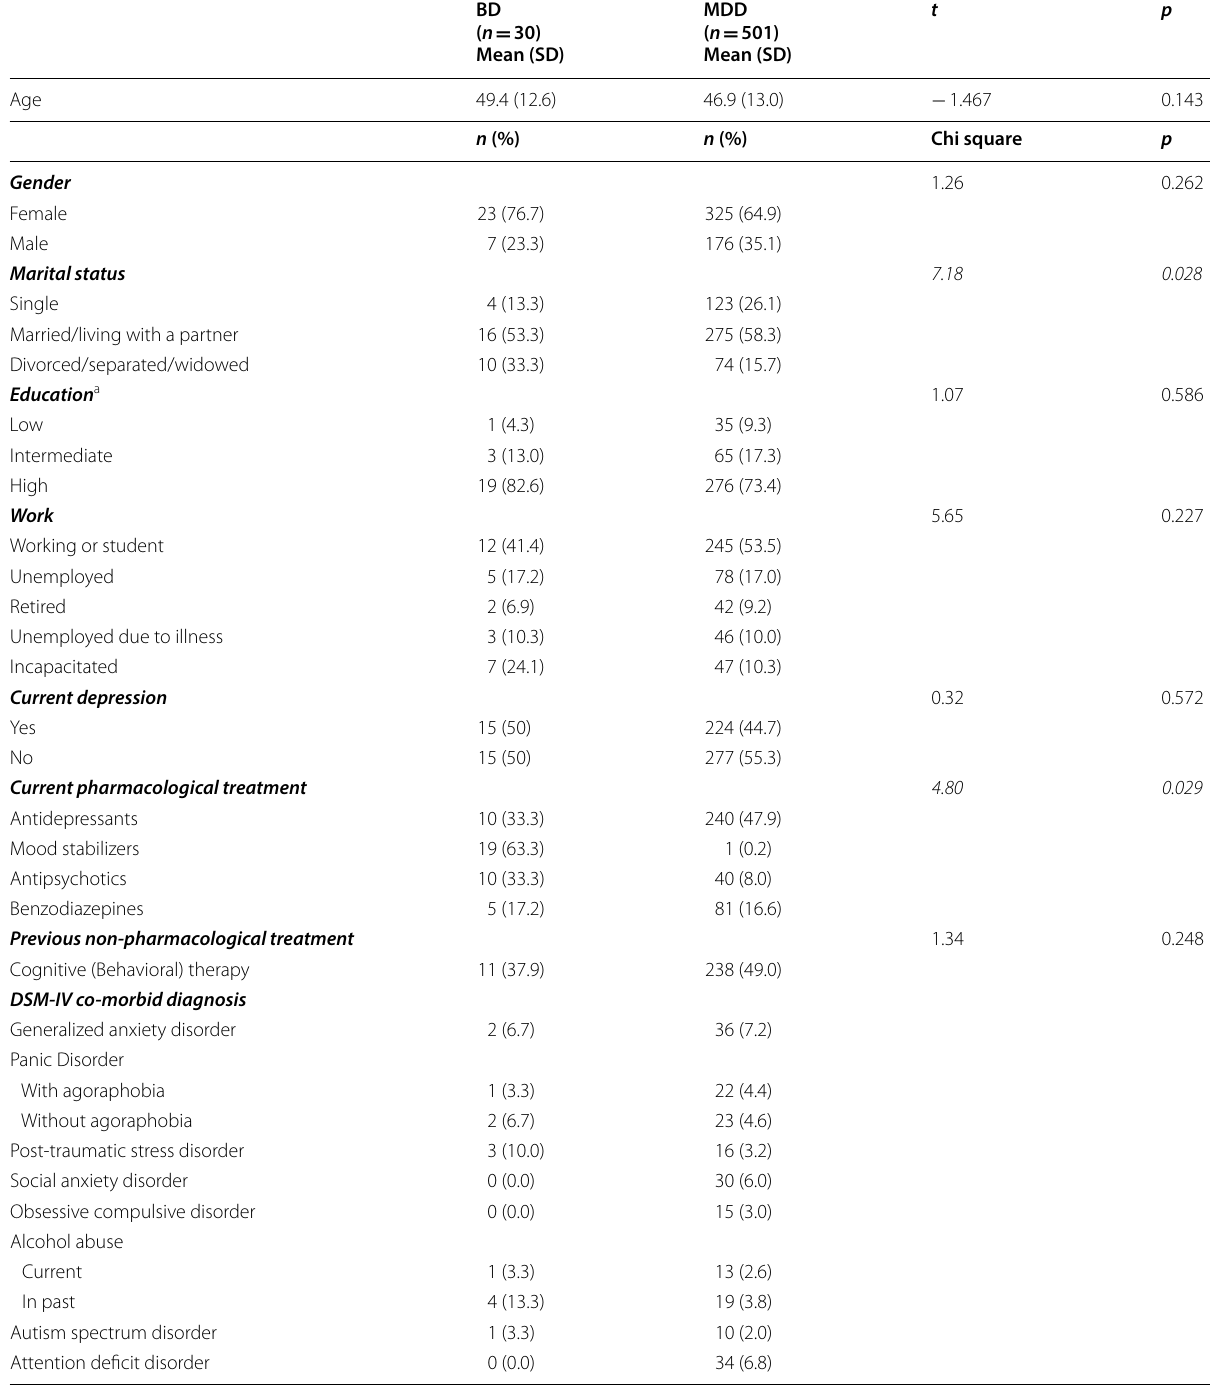
Table 1 Demographic and clinical